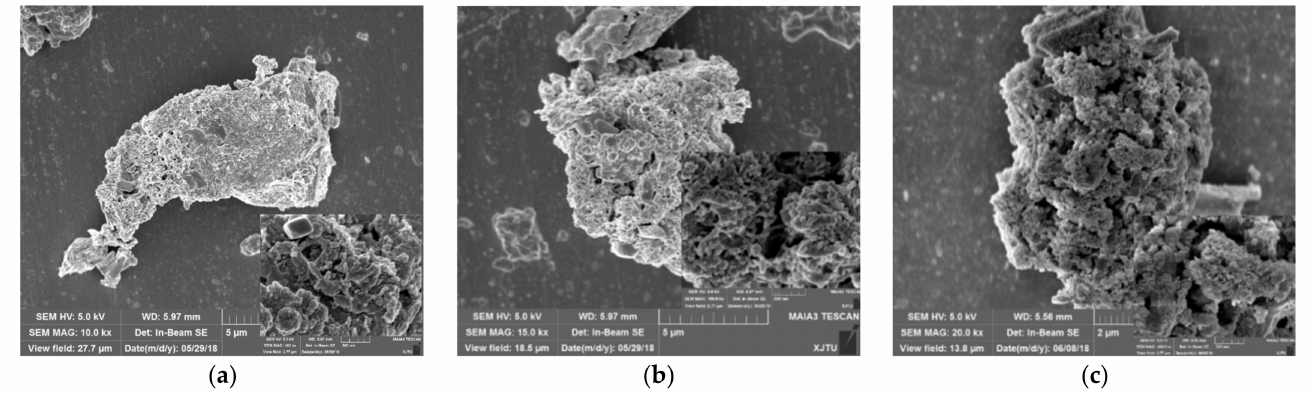
Figure 3. SEM images of catalysts (scale = 2 µ m & 500 nm): ( a ) Fe 0.8 Cu 0.2 /RHA; ( b ) Fe 0.67 Cu 0.33 /RHA; ( c ) Fe 0.5 Cu 0.5